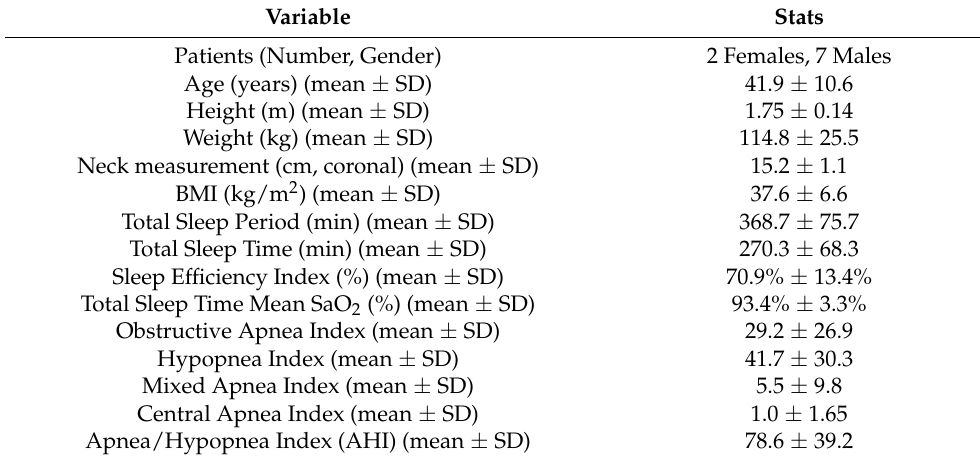
Table 1. Patient demographics and NPSG study